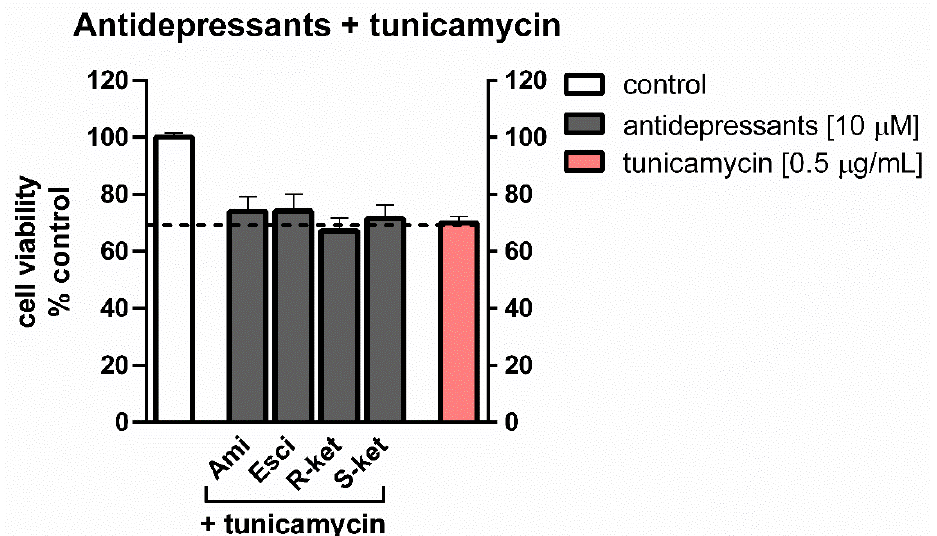
Figure 3. Effects of amitriptyline (Ami), escitalopram (Esci), R-ketamine (R-ket) and S-ketamine (S-ket) on viability of astrocytes during 24-h tunicamycin-induced ER stress. Data are presented as the mean ± SEM and expressed as a percentage of untreated control cells.